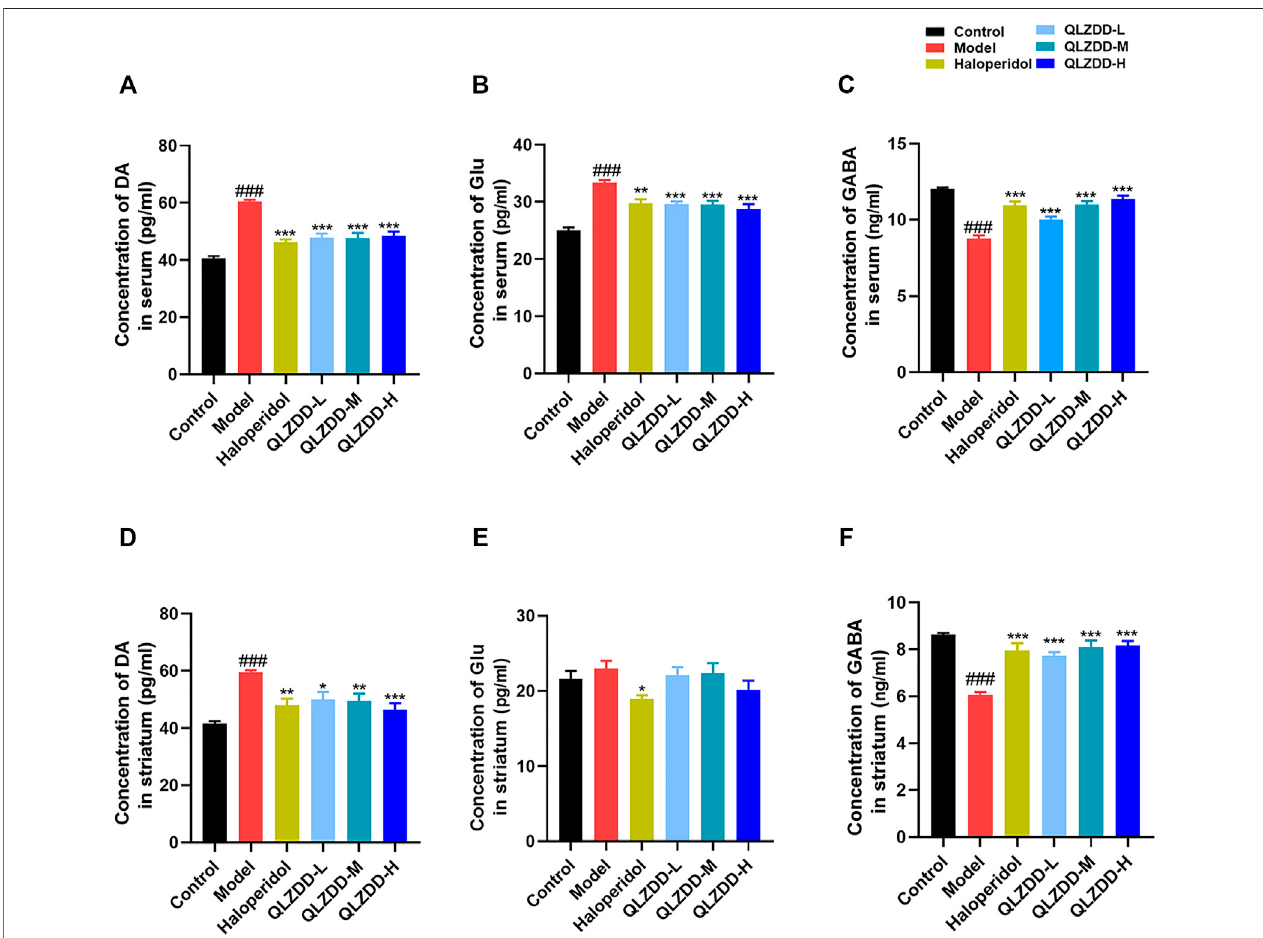
FIGURE3| TheeffectofQLZDDonDA,Glu,andGABA. (A) TheleveloftheDAexpressioninserum, (B) theleveloftheGluexpressioninserum, (C) thelevelofthe GABAexpressioninserum, (D) theleveloftheDAexpressioninthestriatum, (E) theleveloftheGluexpressioninthestriatum,and (F) theleveloftheGABAexpressionin thestriatum.Alldatawereexpressed asmean±SD( n =8mice).One-wayANOVAwasusedtocomparethedataoftheQLZDDgroupstothedataofthecontrolgroup. ### p < 0.001 in comparison with the model group. * p < 0.05, *** p < 0.01, and *** p < 0.001.